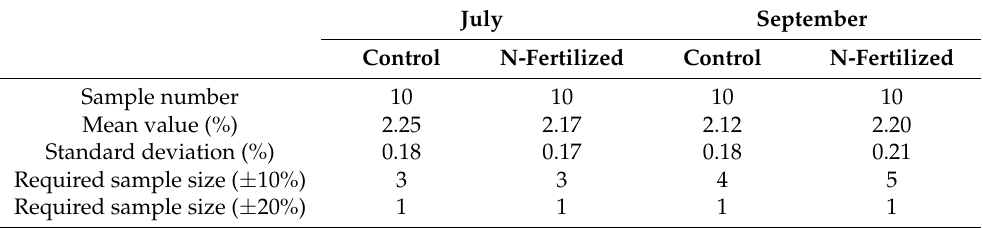
Table 5. Required sample size of leaf N contents within ± 10% and ± 20% of the sample mean at the 95% probability